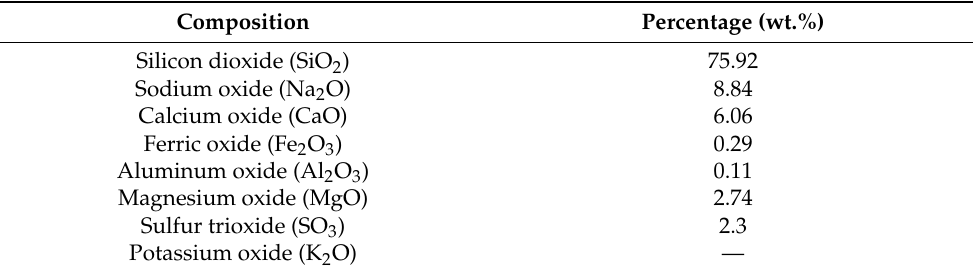
Table 1. Chemical constituents of solar photovoltaic glass powder.